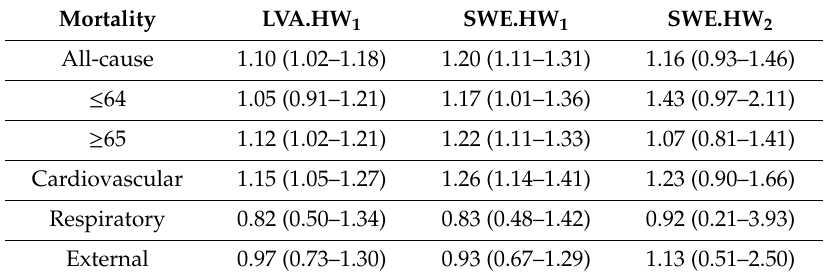
Table 4. Relative Risks (RRs) of mortality with 95% confidence intervals associated with heat waves during the summer months 2009 to 2015 in